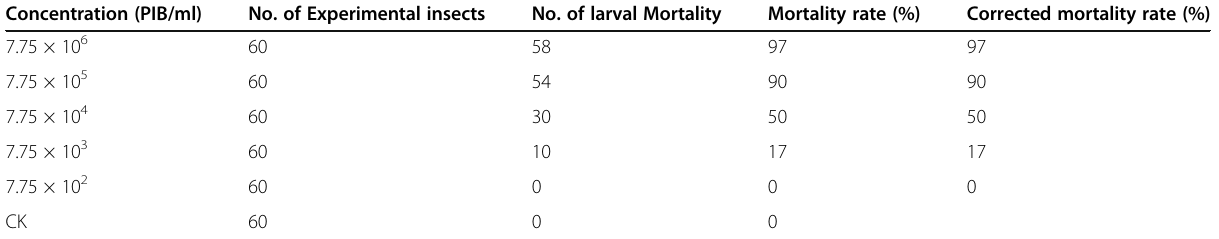
Table 2 Cumulative mortality of 3rd instar larvae of Spodoptera litura infected with viruses at different concentrations Concentration (PIB/ml)